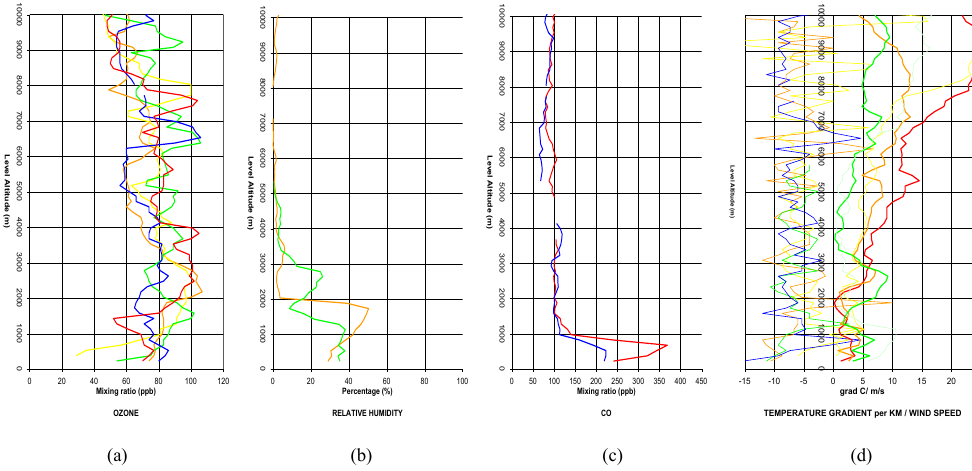
Figure 2. (a). Vertical profiles of summer (JJA) ozone over the Eastern Mediterranean airport of Cairo during the 3-day high ozone period in 3 Fig. 2. (a) Vertical profiles of summer (JJA) ozone over the eastern Mediterranean airport of Cairo during the 3-day high ozone period in the lower troposphere, 30/07 – 1/08/2003 (Profiles: MD20030730023 (red), MA20030730063 (orange), MA20030730103 (yellow), 4 the lower troposphere, 30 July–1 August 2003 (Profiles: MD20030730023 (red), MA20030730063 (orange), MA20030730103 (yellow), MA20030801063 (green), MD20030801054 (blue)), (b). Same as (a) but for relative humidity (c). Same as (a) but for carbon monoxide (CO) 5 MA20030801063 (green), MD20030801054 (blue); (b) same as (a) but for relative humidity; (c) same as (a) but for carbon monoxide (CO); (d) (left), same as (a) but for temperature gradient per km; (right), same as (a) but for wind speed. There are missing profiles in (b) and (c) . (d). (Left), Same as (a) but for temperature gradient per km, (Right), Same as (a) but for wind speed. 6 There are missing profiles in (b) and (c). 7 the summer vertical profiles of ozone over Cairo show sig- nificantly low ozone values at 25–45 ppb, with a minimum to the high ozone period, the corresponding vertical profiles of humidity show considerably higher values in the range of 25–60 % in the 1–4.5 km layer. These relatively high humid- ity levels indicate the presence of air masses originating from the boundary layer. A gradual increase of humidity is ob- served with increasing altitude with a maximum at 4–5 km (Fig. 4b). The CO values in the boundary layer and the lower troposphere (Fig. 4c) are quite comparable to the correspond- ing levels of the high ozone profile. The sharp decrease of air temperature with increasing altitude approaching dry adia- batic lapse rate at 3–4 km indicating weaker static stability where the wind speed shows relatively high values (Fig. 4d).